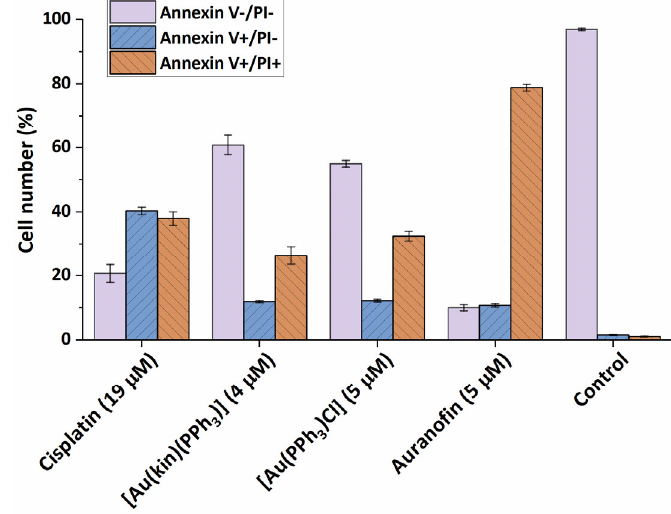
Figure 5. The ability of ( 1 ) and the reference gold(I) complexes [Au(PPh 3 )Cl], Auranofin , and a reference drug Cisplatin to cause the transformation of intact A2780 cells (Annexin V-/PI-) towards early apoptosis (Annexin V+/PI-) and late-stage apoptosis (Annexin V+/PI+) after 24 h of incubation with half-cytotoxic concentrations of the compounds. The changes in all groups were found to be significant at the p < 0.0001 level with respect to the untreated control group.